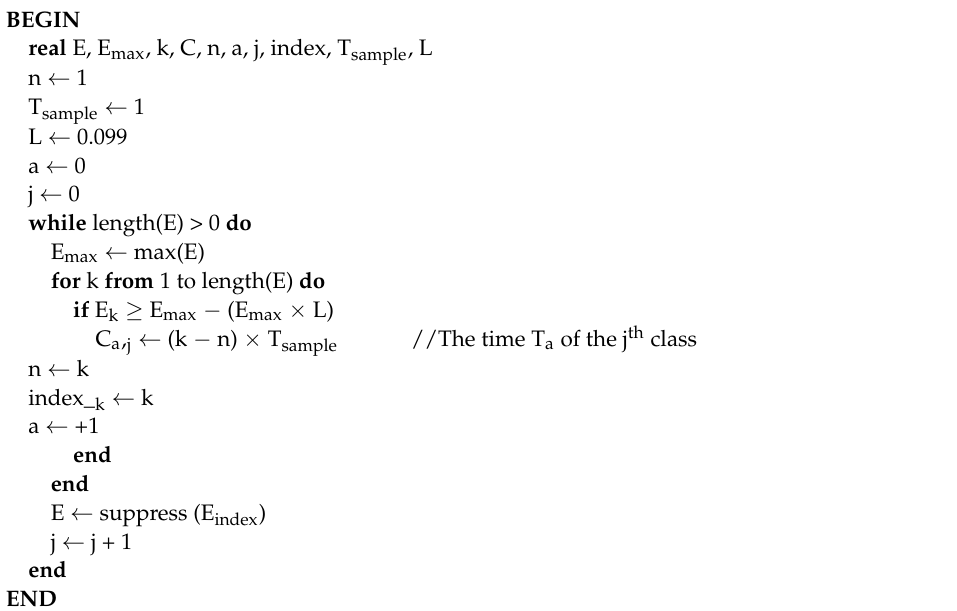
Algorithm 1: class seperation of the signal E